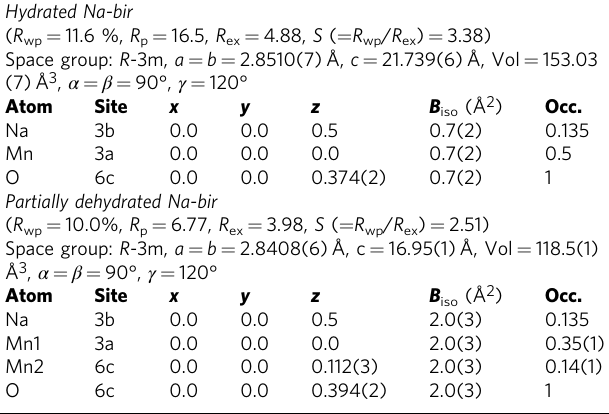
Table 1 Re fi ned structural parameters of hydrated Na-bir and partially dehydrated Na-bir Hydrated